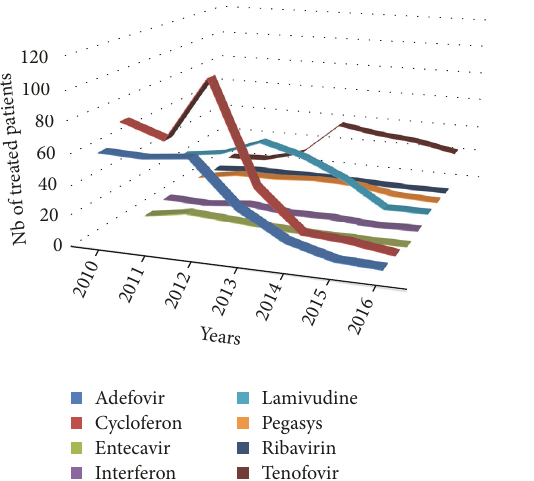
Figure 6: Evolution of the number of patients treated and medicines administered to patients received at CILM between January 2010 and November 2016.